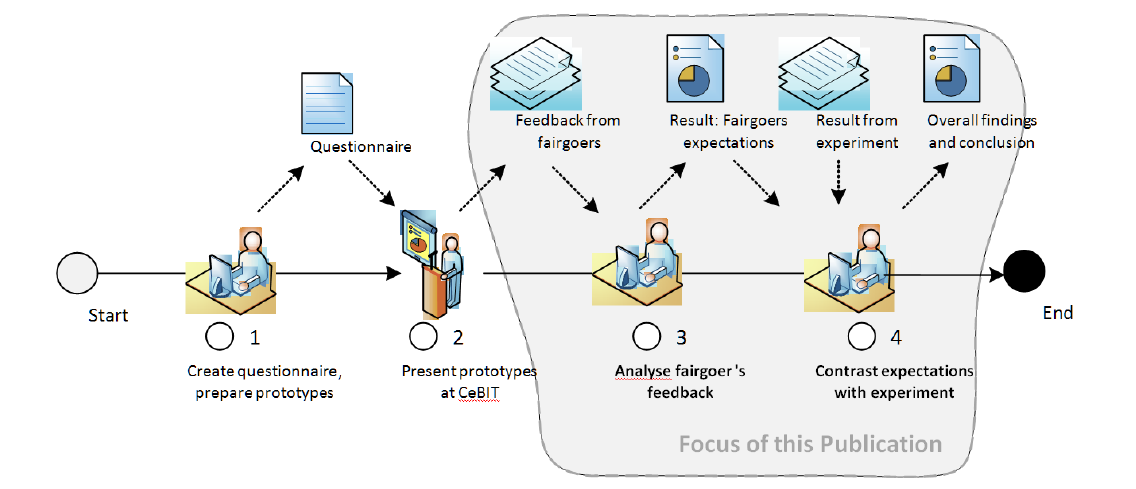
Figure 3. Research process